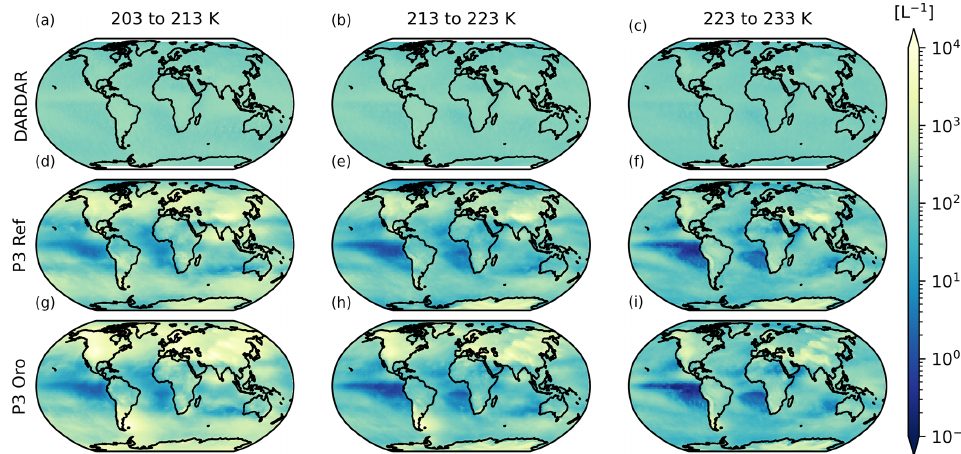
Figure A2. Spatial distributions of ICNC in L − 1 per DARDAR-defined 10K temperature bin for (a–c) 2006–2016 mean DARDAR ICNC > 5µm (Sourdeval et al., 2018) and 5-year annual mean model ICNC for (d–f) P3 Ref (full D19 set-up as per the main text) with no orographic effects and (g–i) P3 Oro with active orographic